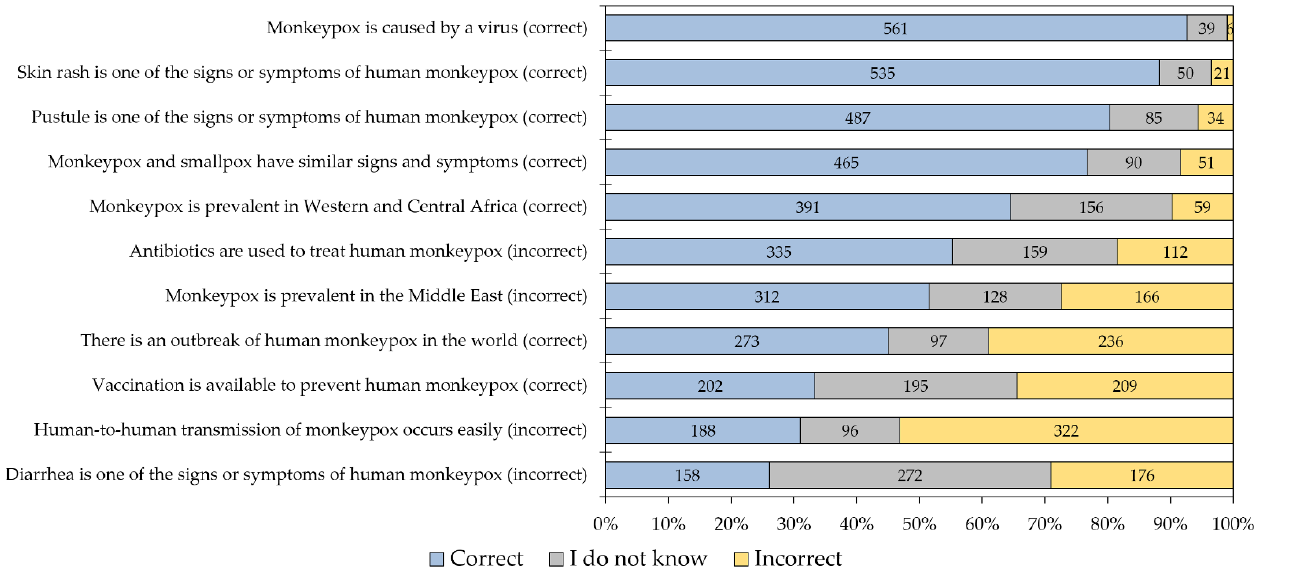
Figure 1. The overall level of human monkeypox knowledge per item among the study